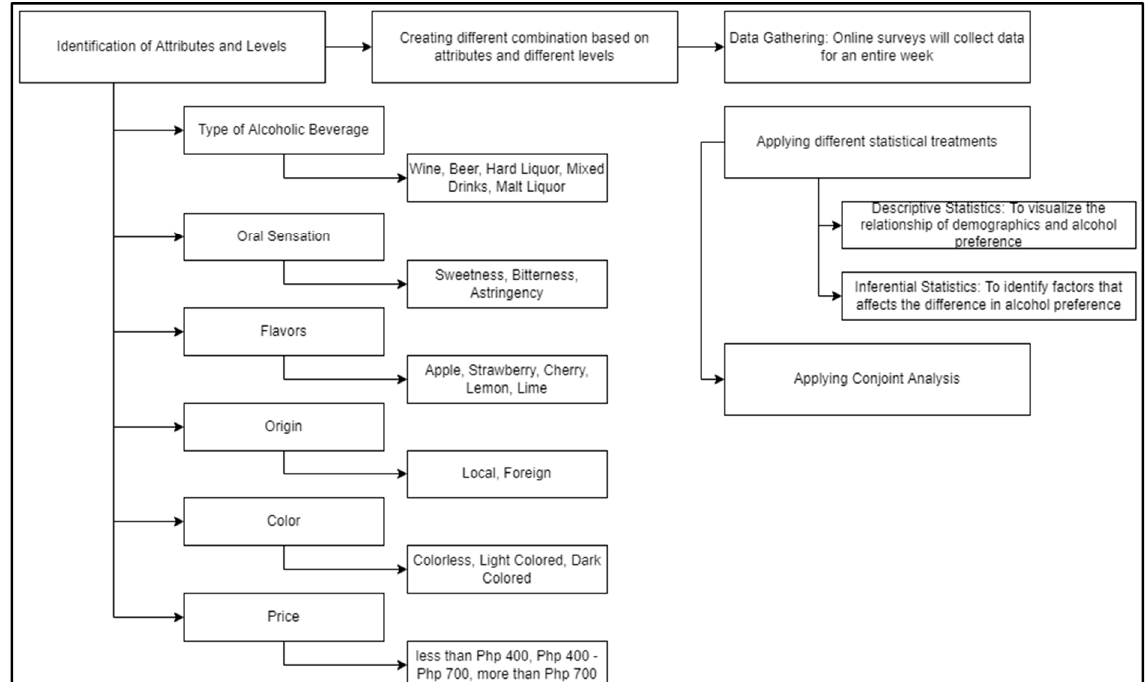
Figure 1. Conceptual